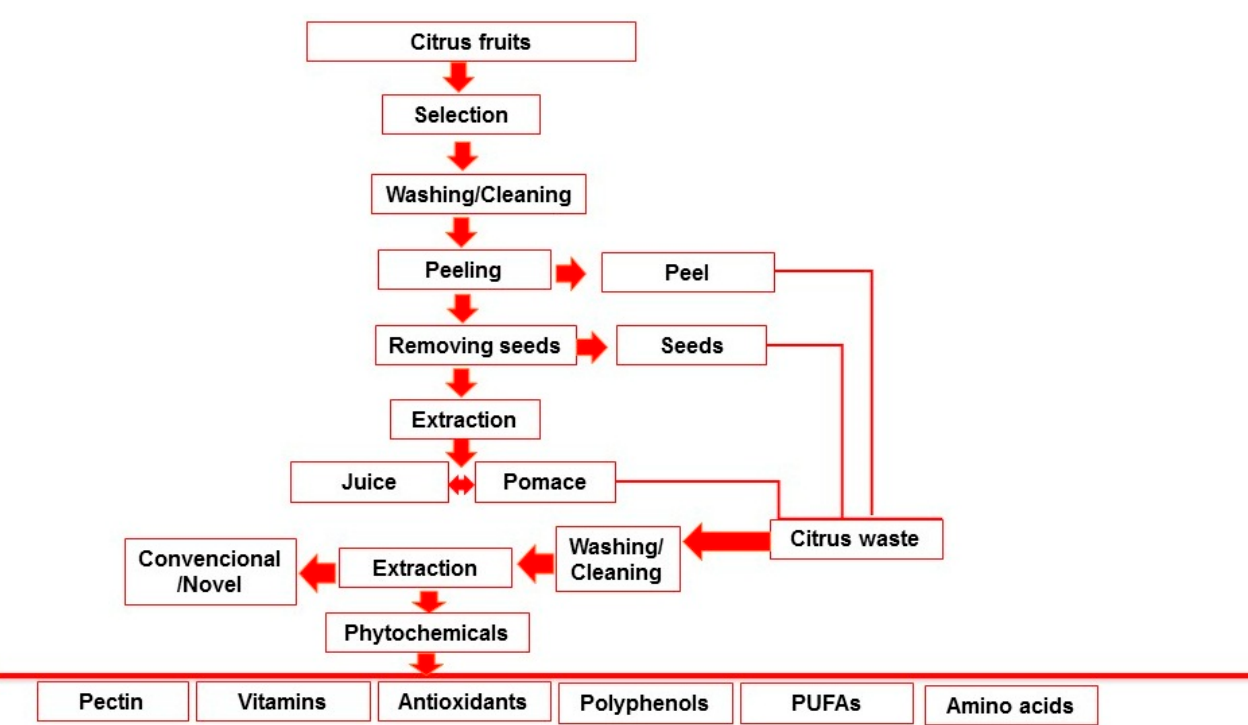
Figure 1. Generation of waste in juice processing.